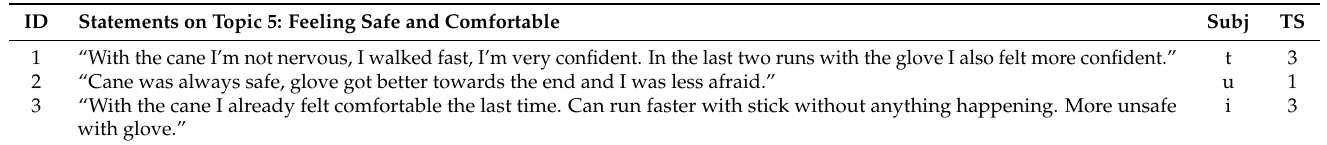
Table A7. Abbreviations used in this table: ID = statement identifier; Subj = subjects; TS = Trial Session.